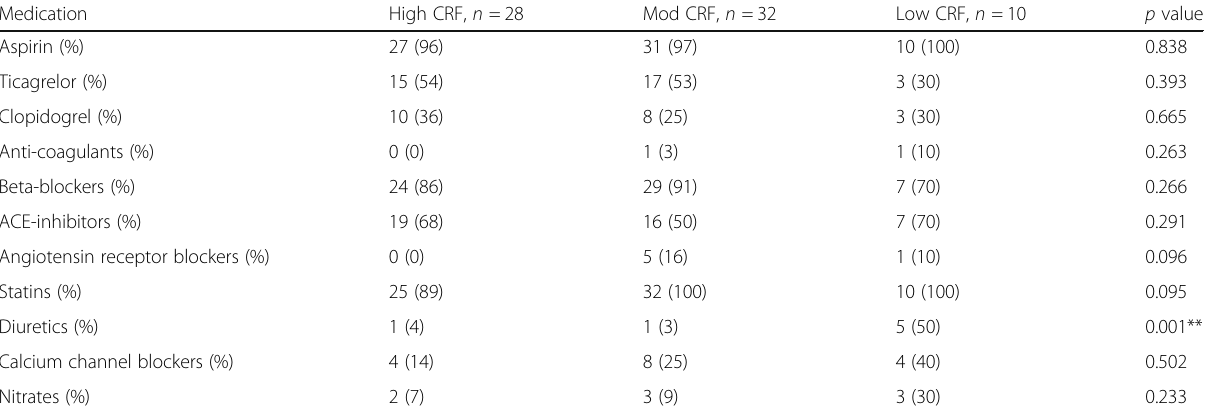
Table 3 Number (%) of Medications Taken by